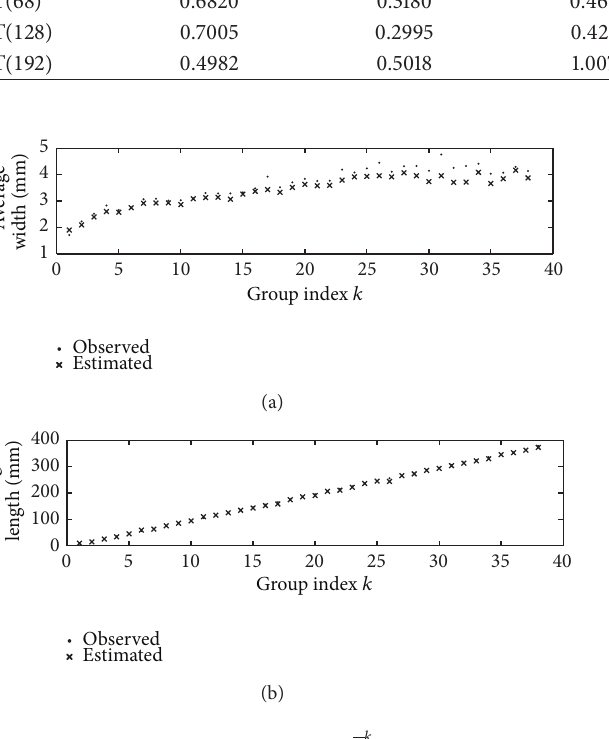
Figure 2: (a) Comparison of observed ℎ ℎ 𝑘 𝑑 width averages taken over groups 𝑘 observed 𝑙 𝑜 and image estimated groups 𝐺 𝑘 (𝑙) (see Table 6). The values obtained from digitized leaves were estimated by using ST (68) . The values obtained from digitized leaves were estimated by using ST (128) .